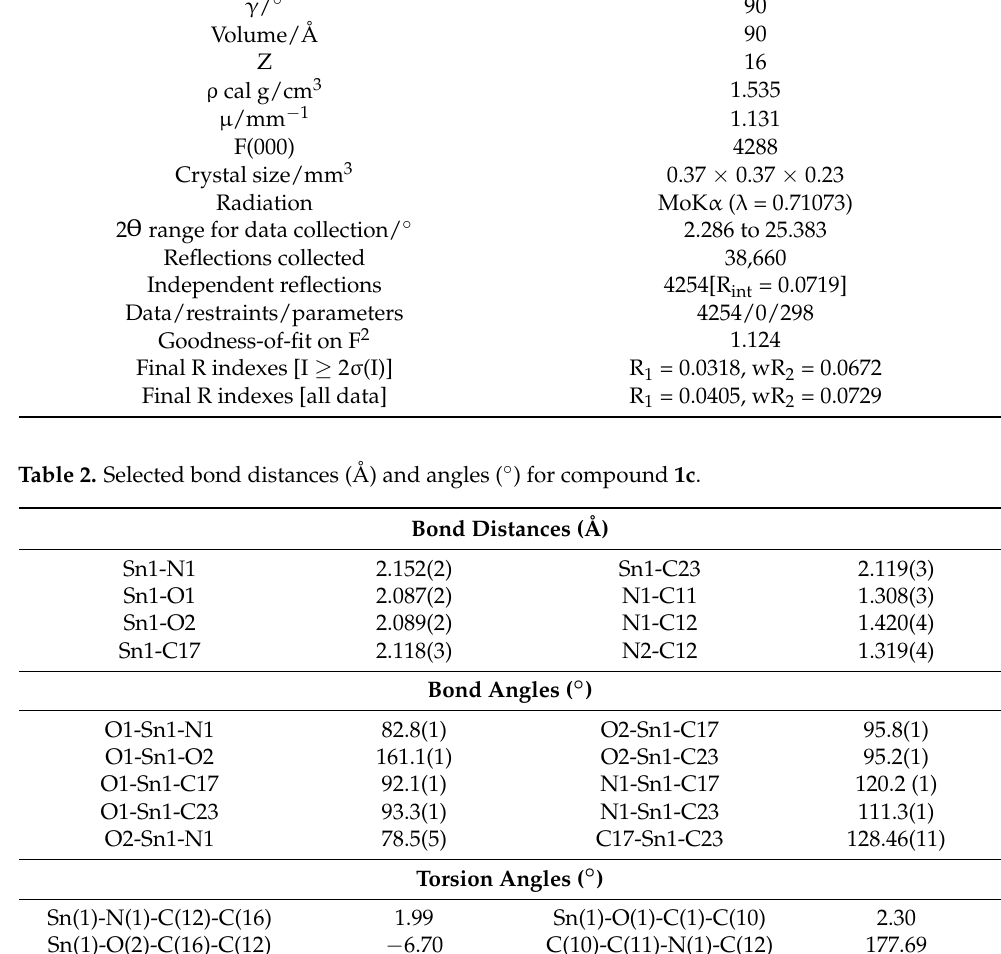
Table 1. Crystallographic and structure refinement data for compound 1c .